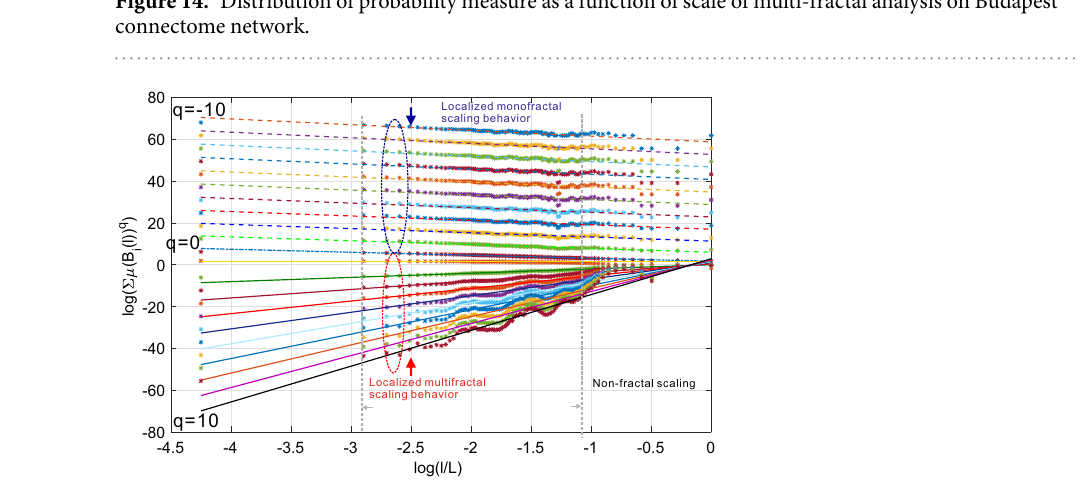
Figure 15. Coexistence of localized multi-fractal and mono-fractal scaling in the Budapest connectome